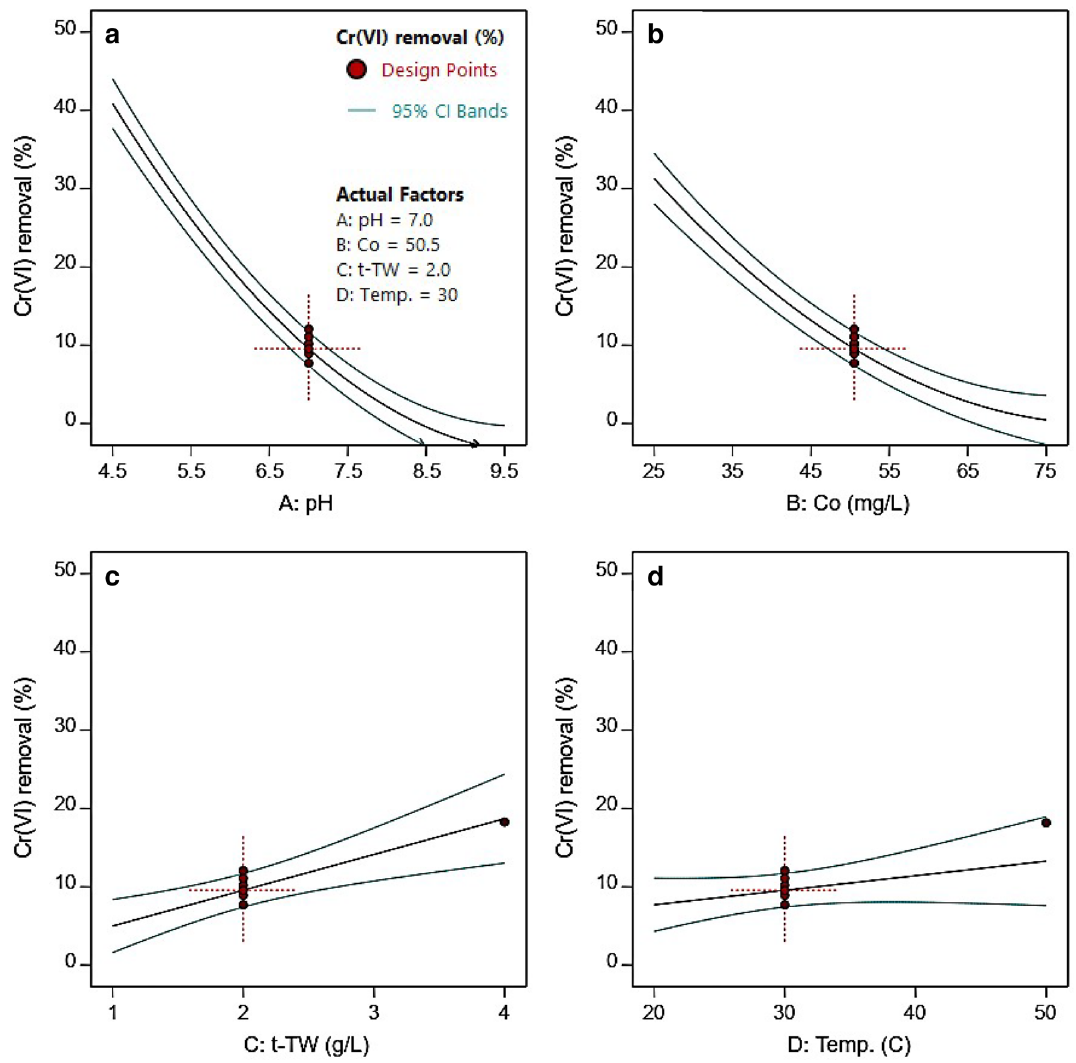
Figure 4. One-factor effects plots of ( a ) pH, ( b ) initial Cr(VI) concentration, ( c ) t-TW dosage, and ( d ) temperature on Cr(VI) adsorption from